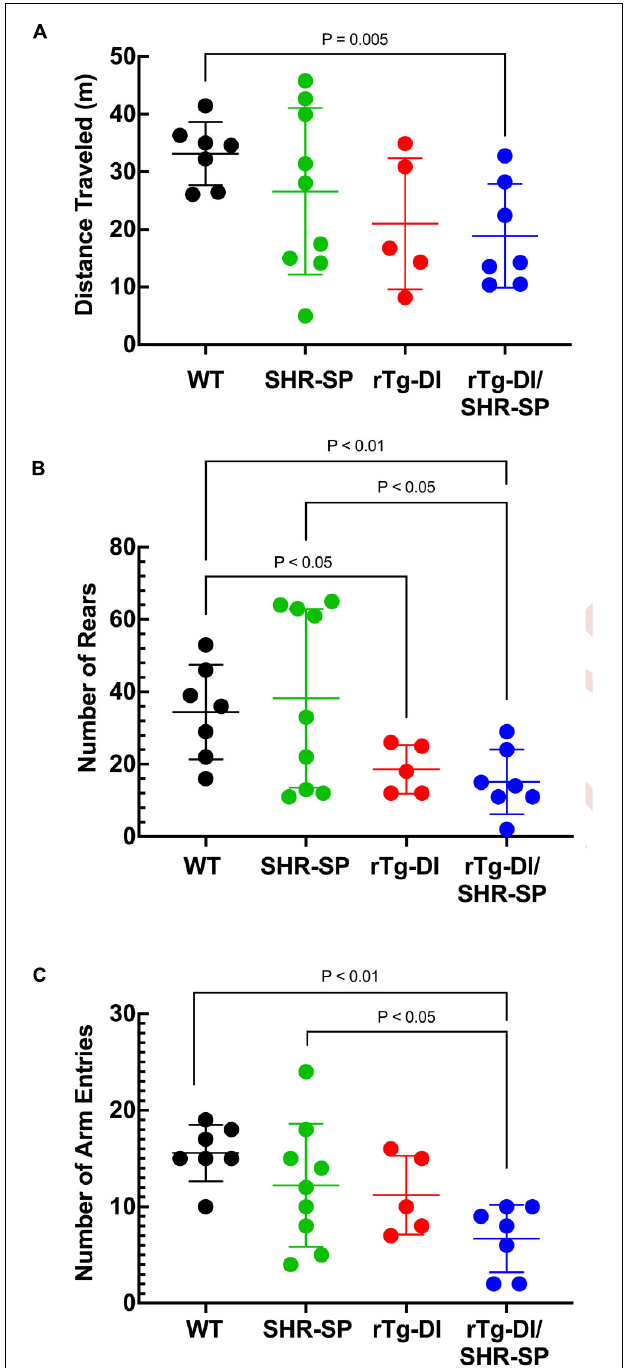
FIGURE 4 | Behavioral deficits of 7 M rTg-DI and bigenic rTg-DI/SHR-SP rats. Bigenic rTg-DI/SHR-SP rats were not significantly different than rTg-DI rats in the number of rears (A) or distance traveled (B) in the open field. Similarly, no significant differences were found between rTg-DI and bigenic rTg-DI/SHR-SP animals in the number of arm entries (C) in Unreinforced Radial Arm Maze (URAM). WT rats (black; n = 7), SHR-SP (green; n = 9), rTg-DI (red; n = 5), and bigenic rTg-DI/SHR-SP (blue; n = 7). Data presented are the mean ± SD. These data show that the hypertensive SHR-SP background does not significantly impact behavioral deficits of rTg-DI rats at 7 M of age.